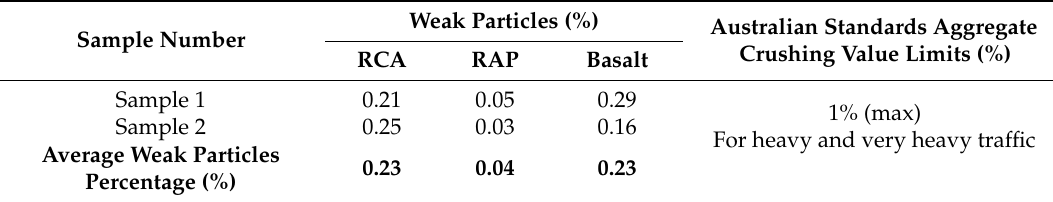
Table 7. The Results of Weak Particle Test for Coarse Aggregates and Weak Particles Percentage Limits for Dense Graded Asphalt Based on Australian Standards.